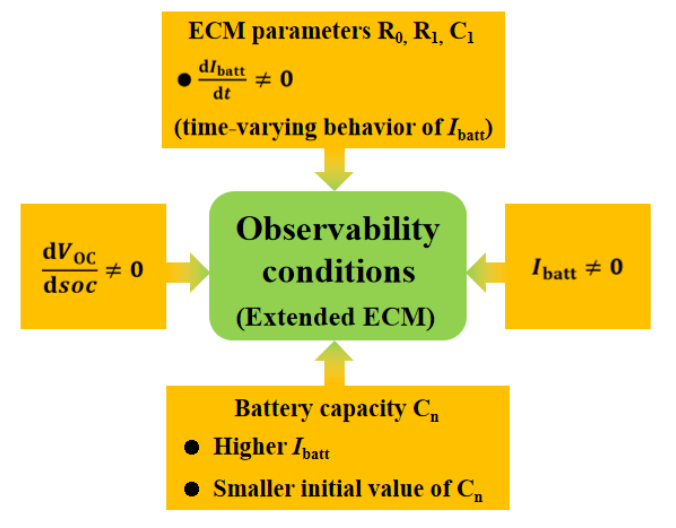
Figure 6. Schematic resume of the necessary observability conditions for extended